Question: In one sentence, what is this figure communicating?
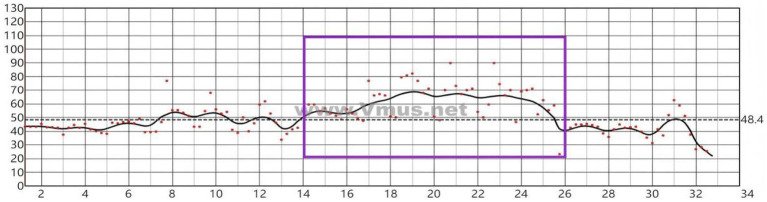
Answer: Friedrich Gulda Macro Tempo Curve.